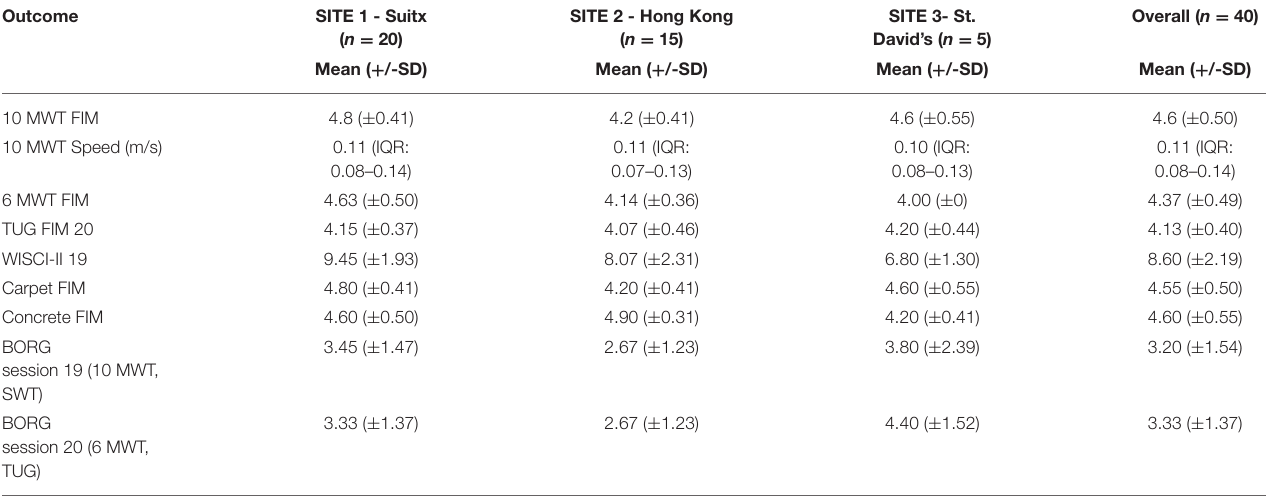
TABLE 5 | Functional outcome summary. Outcome